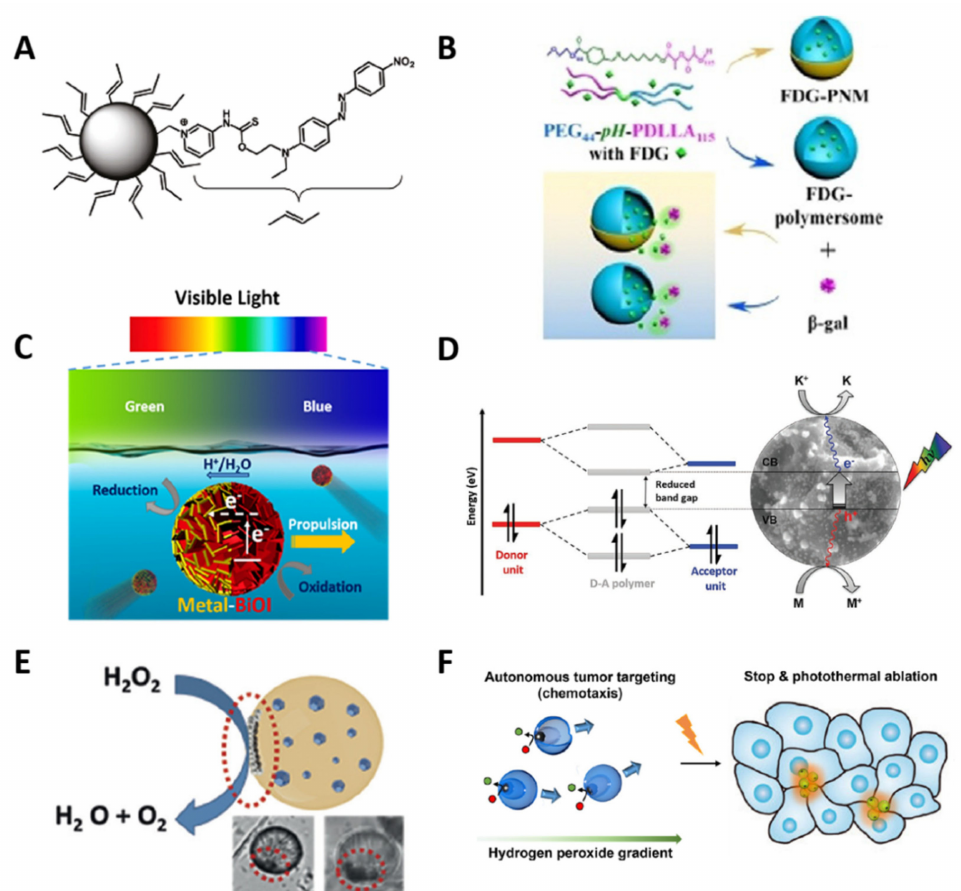
Figure 10. Schematic representation of light-stimulated polymeric micro/nanomotors for propul- sion, by ( A ) an azobenzene-coated crosslinked polystyrene nanomotor, reprinted with permission from [341], copyright 2011, American Chemical Society; ( B ) cargo transport—an NIR-photoactive polymersome nanomotor for doxorubicin delivery, reprinted with permission from [345], copyright 2020, John Wiley and Sons; ( C ) visible-light-photosensitive micromotors, reprinted with permission from [346], copyright 2017, American Chemical Society; ( D ) an organic polymer sulfur semiconductor and nitrogen donor/acceptor polymer, reprinted with permission from [347], copyright 2020, John Wiley and Sons; ( E ) light-stimulated and catalytic micromotors enhance the biosensing detection, reprinted with permission from [348], copyright 2017, John Wiley and Sons; and ( F ) NIR thermal and catalytic polymeric nanomotors, reprinted with permission from [349], copyright 2018, American Chemical